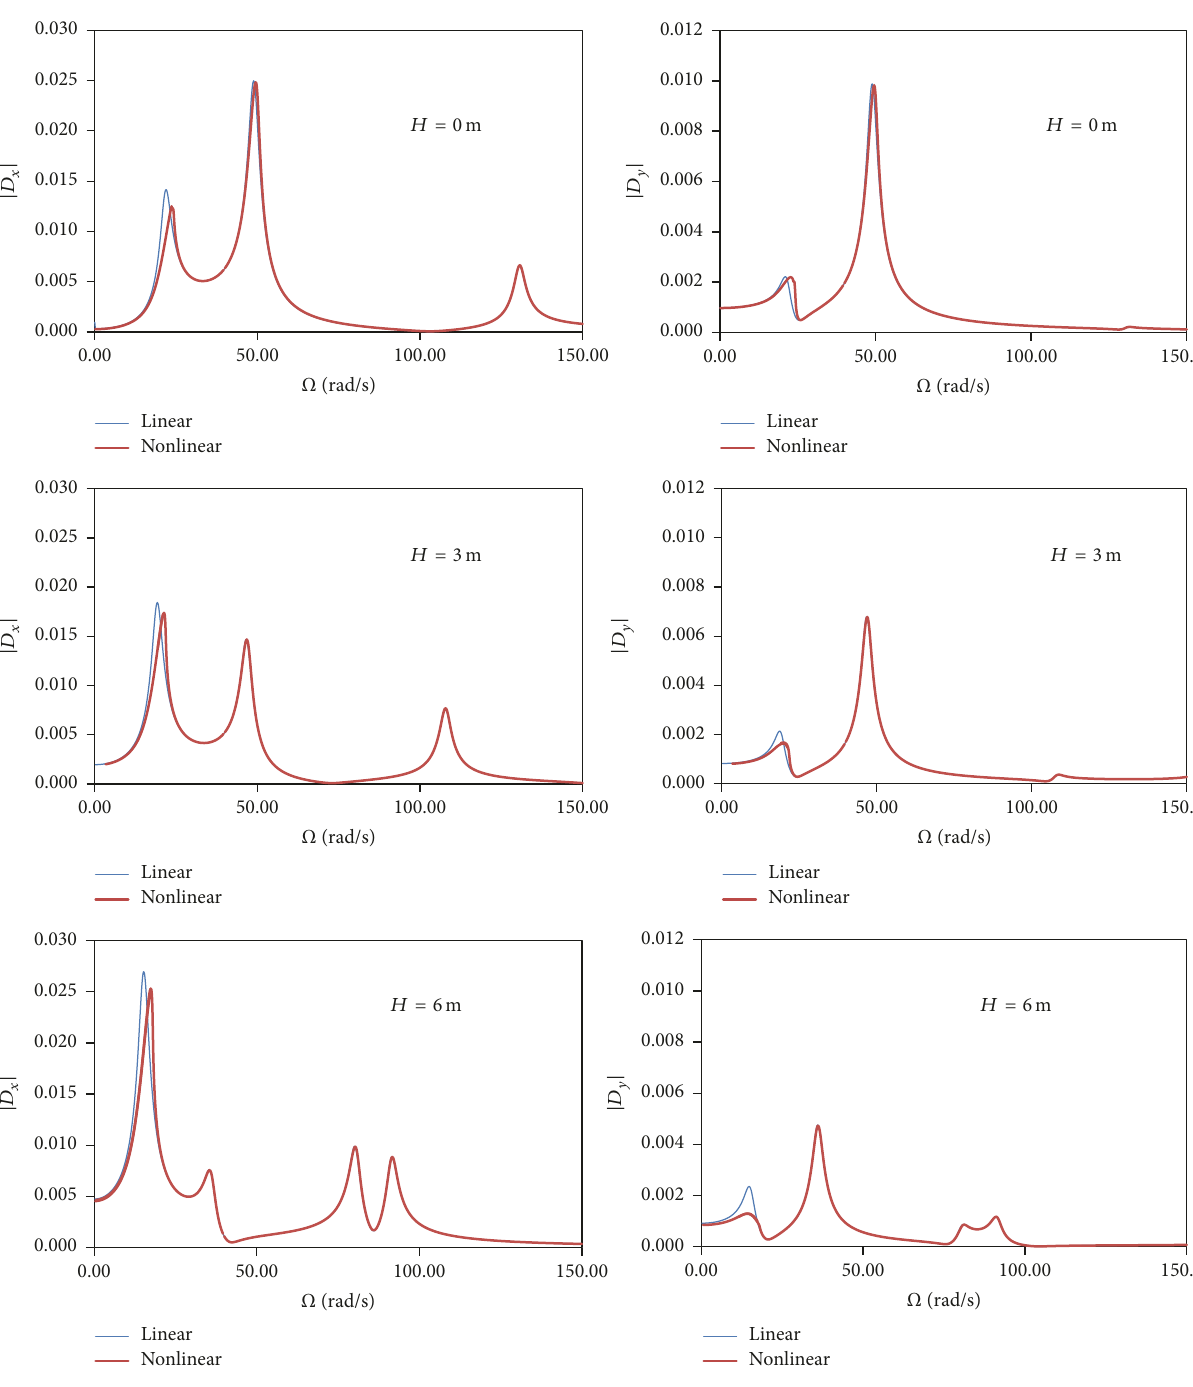
effect of nonlinearity is negligible. In this case, due to the symmetry of the displacement field, the lateral motion of the top node is